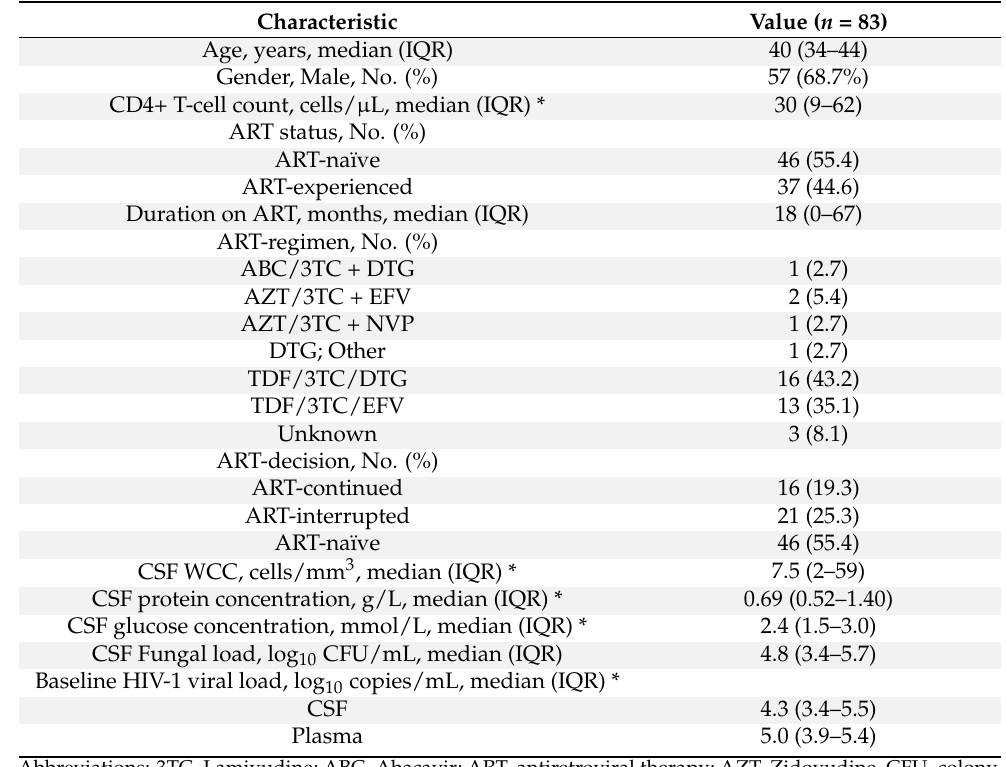
Table 1. Baseline characteristics of the 83 participants